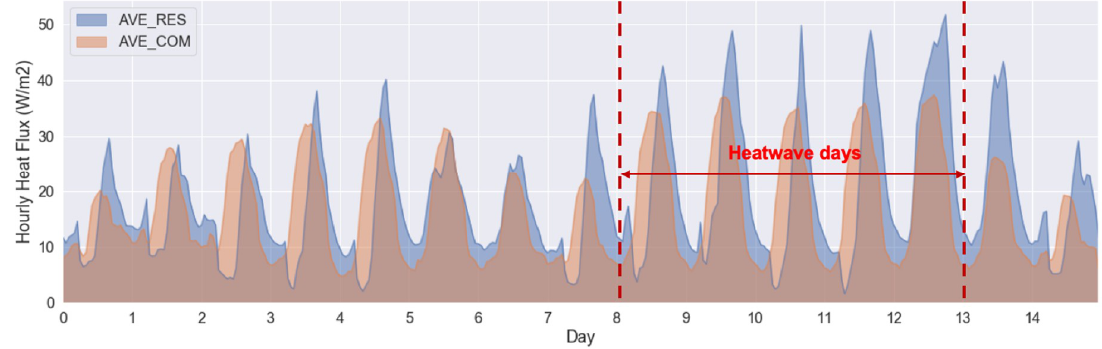
Figure 15. Hourly heat flux from the residential and commercial sectors.